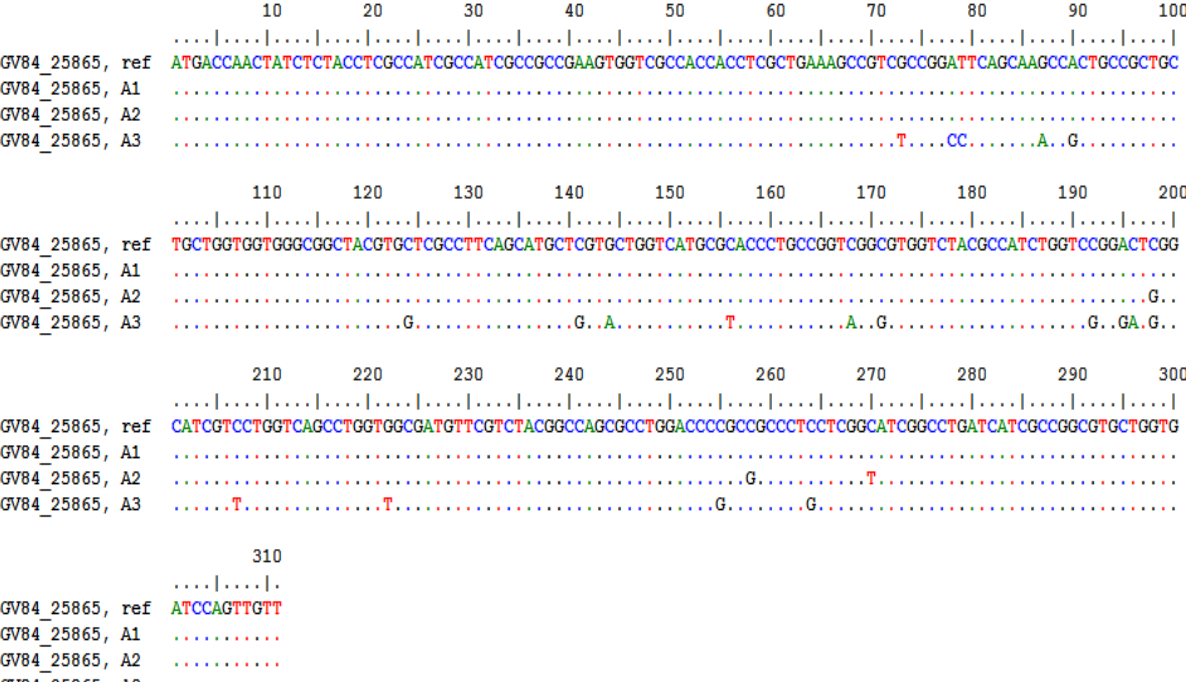
Figure (2): Sequence Analysis of The QacE Reference Gene with Twenty-Six Changes Occurring for P.aeruginosa Isolates PS-2, Ps-3, Ps-4, and Ps-5 Using The DNASTAR Lasergene Edit Seq